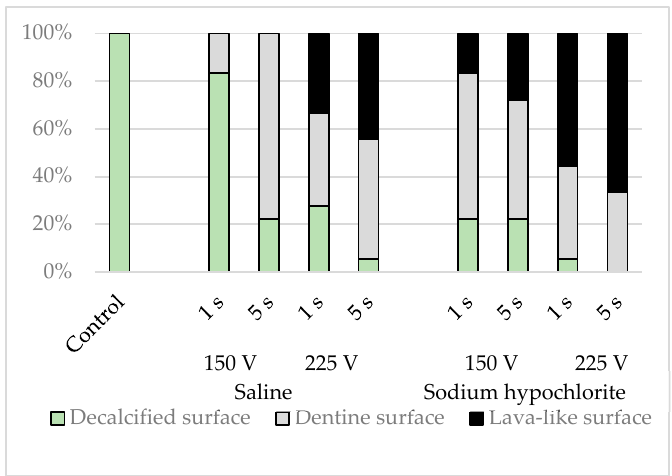
Figure 7. Classi fi cation results of simulated root canal walls by morphology. Figure 7. Classification results of simulated root canal walls by morphology.